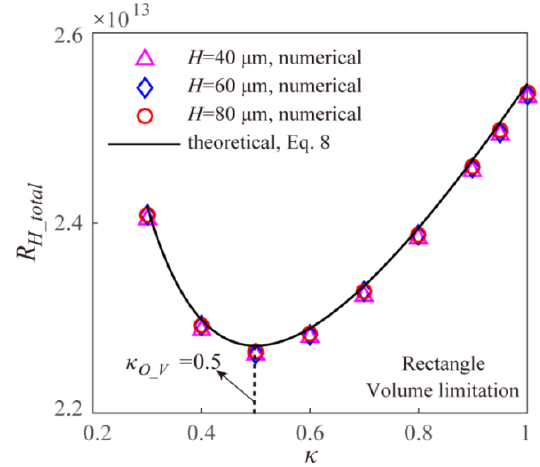
Figure 4. E ff ect of width ratio on the total EOF fluidic resistance in the Y-shaped elemental rectangular microchannel bifurcation with di ff erent channel height under the volume limitation.